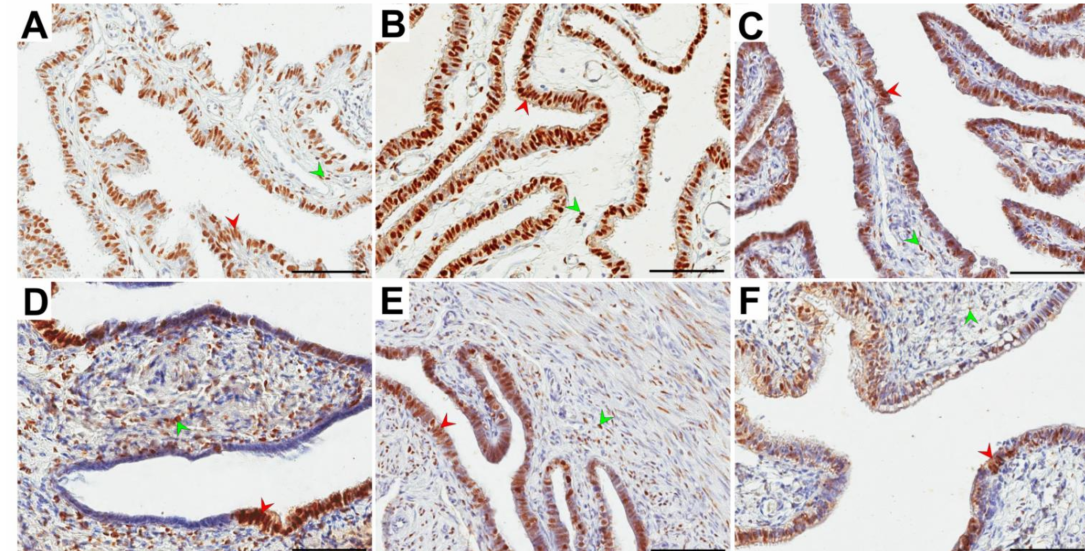
Figure 3. Representative light micrographs of the nuclear immunolocalization (brown color) of progesterone receptor (PR) in the glandular epithelium (red arrowheads) and the stroma (green arrowheads) of the ampulla ( A – C ) and isthmus ( D – F ) of the fallopian tubes in postmenopausal women for whom 1–5 years ( A , D ), 6–10 years ( B , E ) and ≥ 11 years ( C , F ) had elapsed between the last menstrual period and surgery. Note that in the glandular epithelium, immunonegative PR cells in the form of clusters were usually observed. Scale bar—50 µ m.